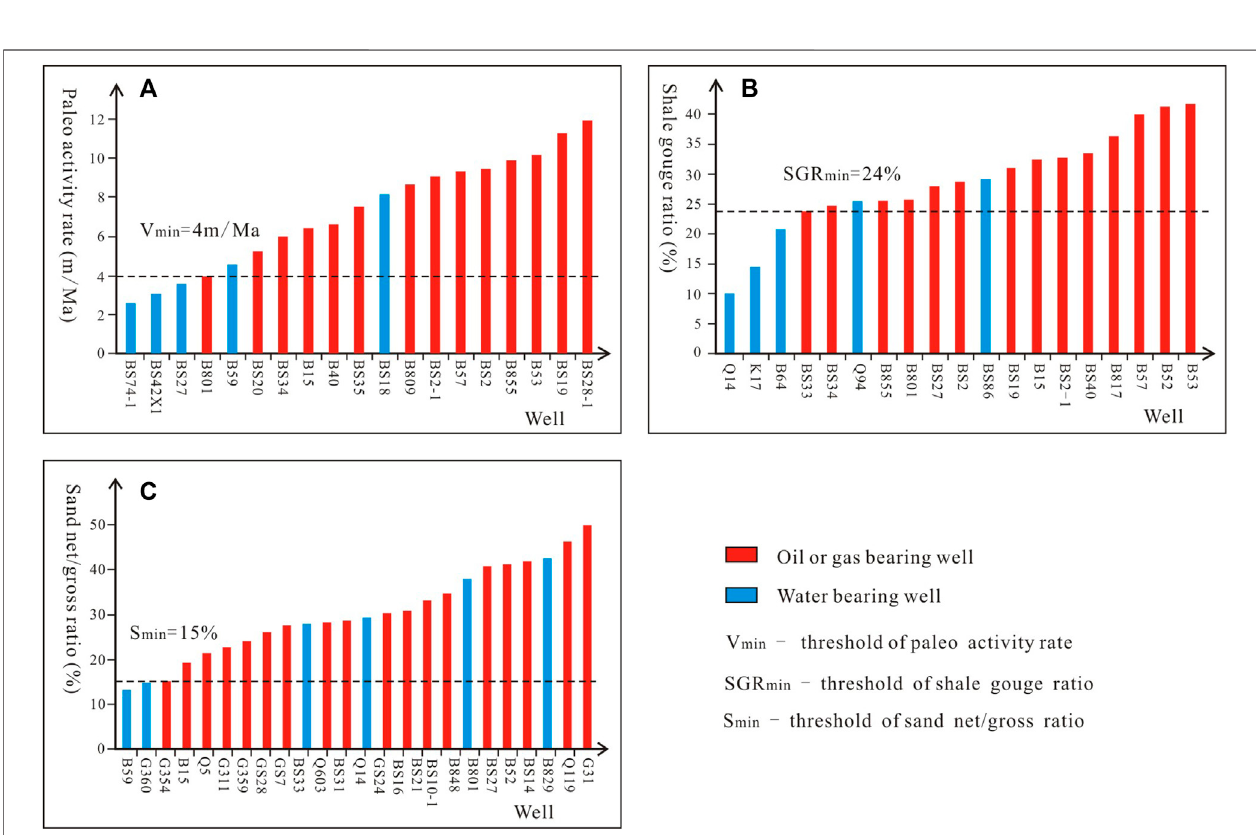
FIGURE 7 | Parameter thresholds of hydrocarbon transportation and accumulation in the Ban 2 oil group in the Qikou Sag. (A) Threshold of hydrocarbon transportation of oil-source faults. (B) Threshold of laterally sealing positions of faults. (C) Threshold of sand bodies storing oil and gas.